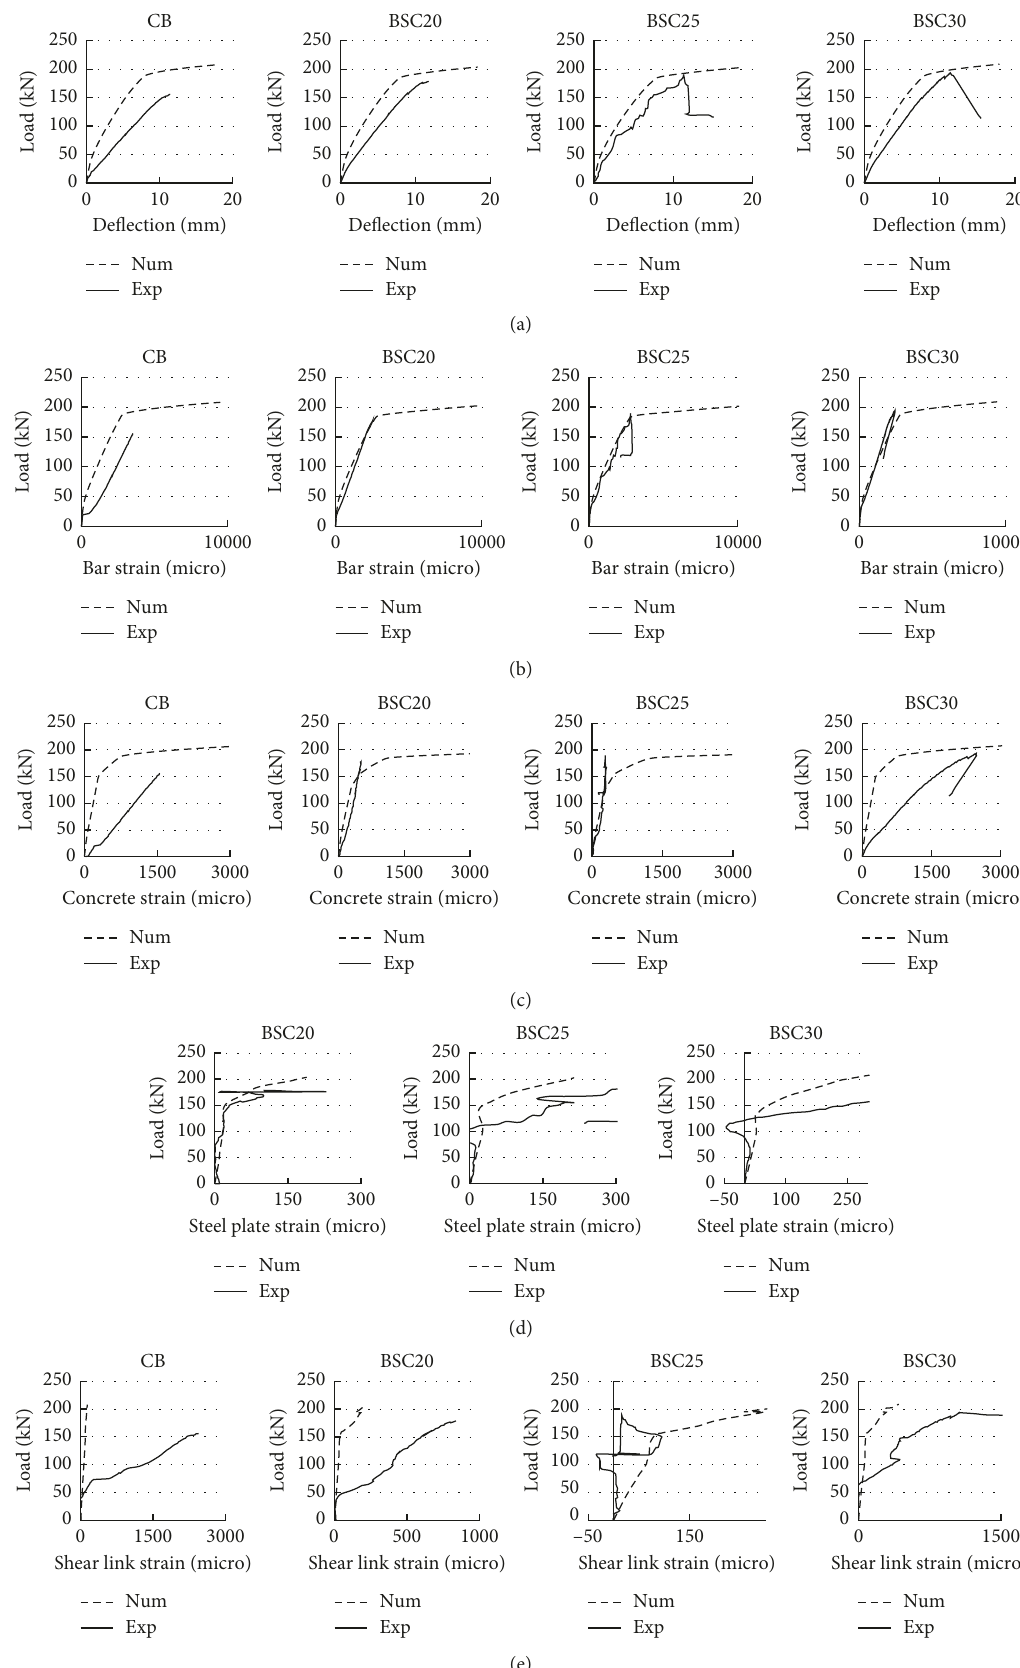
Figure 7: Comparison of numerical and experimental results: (a) comparison of numerical and experimental load-midspan deflection; (b) comparison of numerical and experimental flexural reinforcement strain; (c) comparison of numerical and experimental concrete strain at midspan; (d) comparison of numerical and experimental steel plate strain; (e) comparison of numerical and experimental shear link